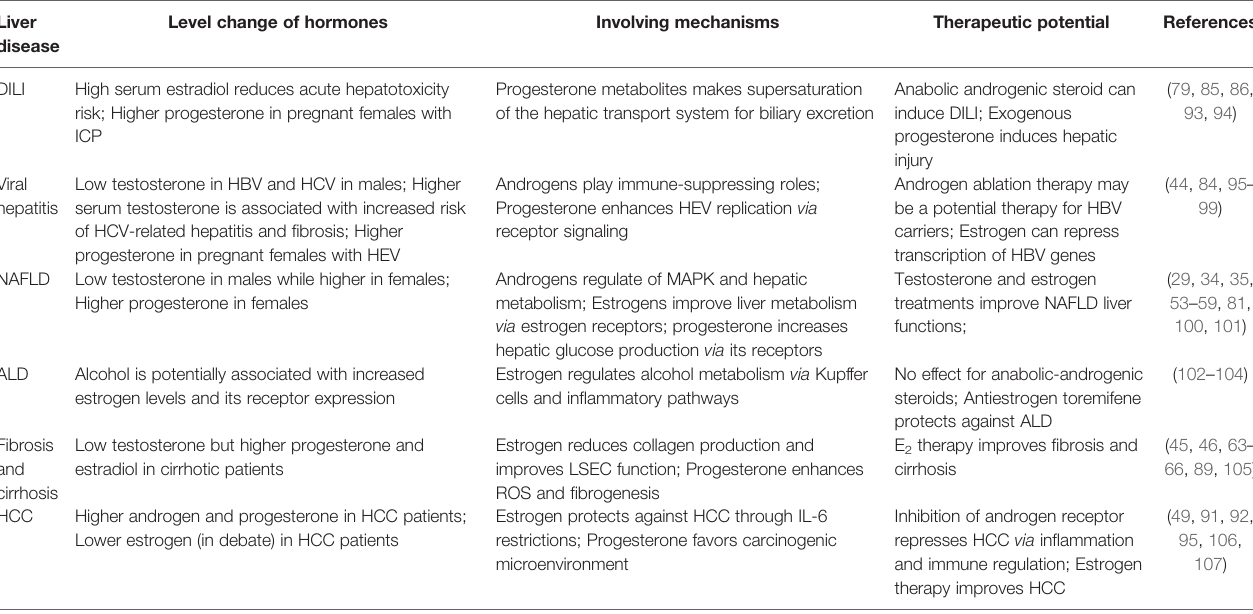
TABLE 1 | The involving roles and therapeutic potentials of sex hormones in liver